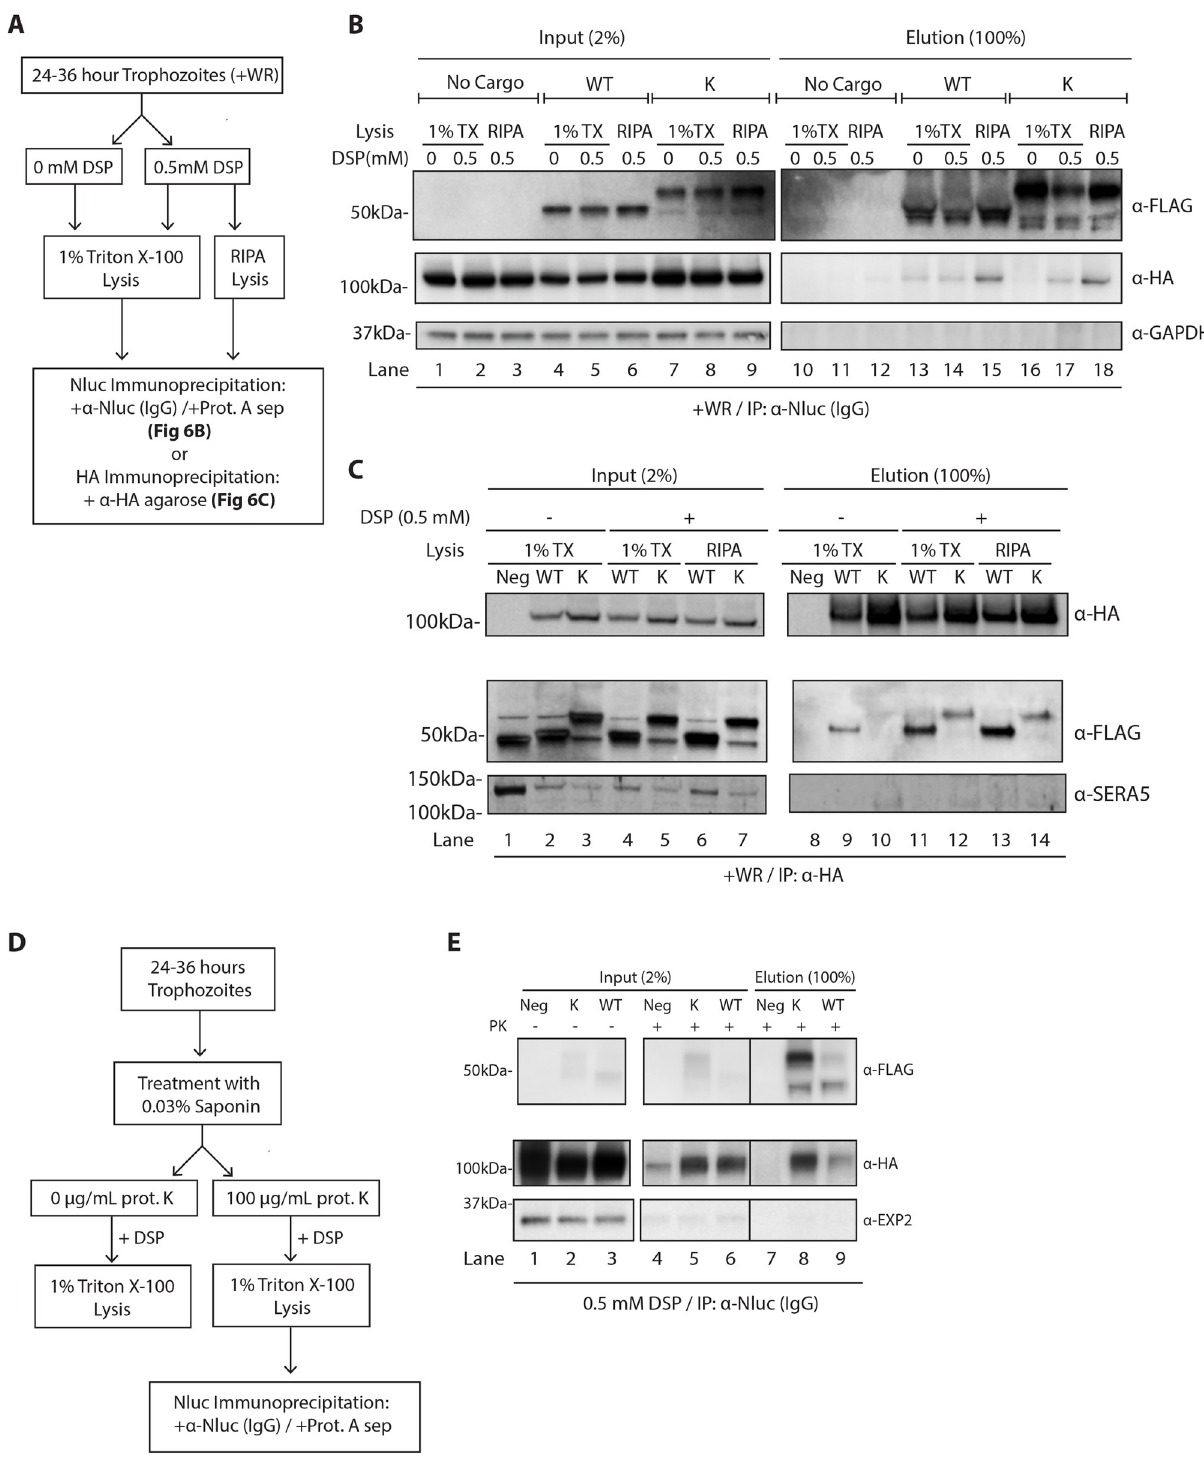
Fig 6. ER-located HSP101 interacts with Hyp1-Nluc-mDHFR-3xFLAG irrespective of Hyp1 PEXEL processing. (A) Schematic of parasite treatment and the subsequent co-immunoprecipitation to assess the interaction between Hyp1 reporters and HSP101. (B) Western blot of anti-Nluc immunoprecipitation performed with HSP101-HA glms parasites expressing WT or P5 Lys (K) Hyp1-Nluc-mDHFR-3xFLAG. Where indicated, parasites samples were crosslinked with 0.5 mM DSP and lysed with either 1% TX-100 buffer or RIPA buffer. The data indicate that the mutant PEXEL reporter engages with HSP101 despite residing in the ER and not being cleaved by plasmepsin V. (C) Reciprocal anti-HA immunoprecipitation was